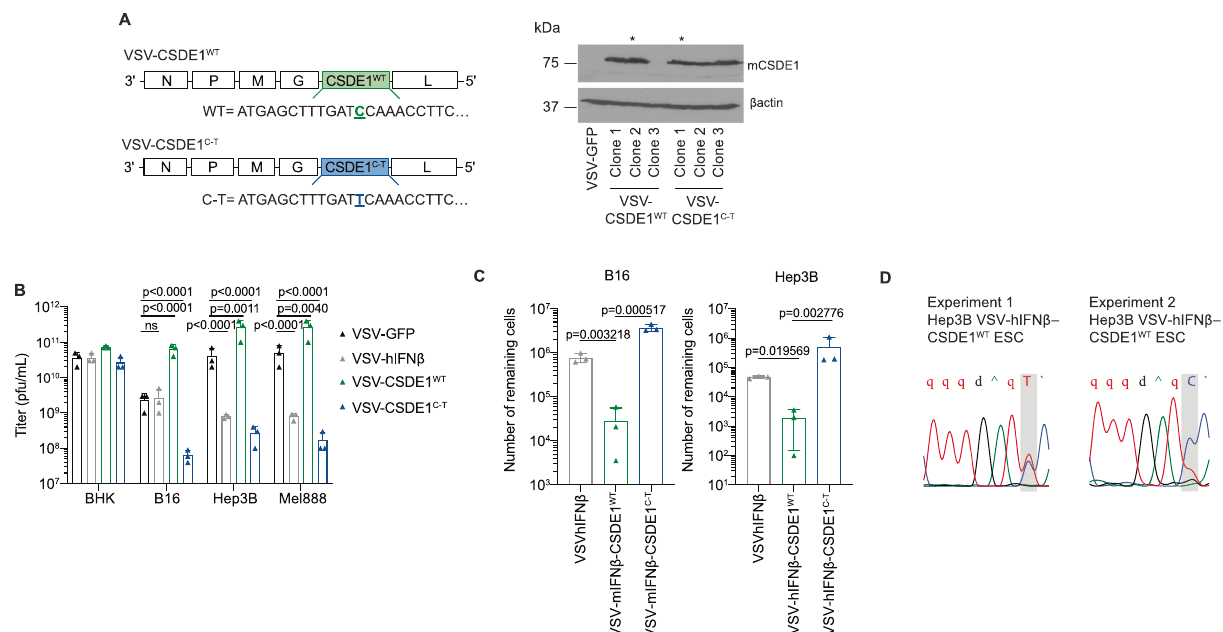
Fig. 4 CSDE1 expressed from the virus enhances replication. A Viruses expressing CSDE1 WT and CSDE1 C-T were constructed and validated by western blotting for the expression of CSDE1. Stars indicate clones that were used in subsequent experiments. Representative of three separate experiments. B BHK (hamster), B16 (mouse), Hep3B, and Mel888 (human) cell lines were infected with VSV-GFP, VSV-hIFN- β , VSV-CSDE1 WT , or VSV-CSDE1 C-T at an MOI of 3 (triplicate wells per cell line). Forty-eight hours later, virus was titered on BHK cell by plaque assay. Representative of three separate experiments. C Murine B16 or human Hep3B cells were infected (MOI 0.01) with VSV-IFN β , VSV-IFN- β -CSDE1 WT , or with VSV-IFN- β -CSDE1 C-T viruses (using species- matched IFN β genes) for 21d as in “ Methods ” and ref. 10 . Surviving cells were pooled and counted. D Hep3B cells were infected (MOI 0.01) with the VSV- hIFN β -CSDE1 WT virus for 21d as in “ Methods ” and ref. 10 . Surviving cells were pooled and genomic DNA prepared. Sanger sequencing of CSDE1 is shown for two independent experiments. In these experiments, as well as in two other experiments, a mixed population of mutated and unmutated cells were selected. Means ± SD of three technical replicates are shown. P -values were determined using a two-way ( B ) or one-way ( C ) ANOVA with a Tukey ’ s multiple comparisons post test on log-transformed data. Statistical signi fi cance was set at p < 0.05, ns > 0.05. Source data are provided as a Source Data fi